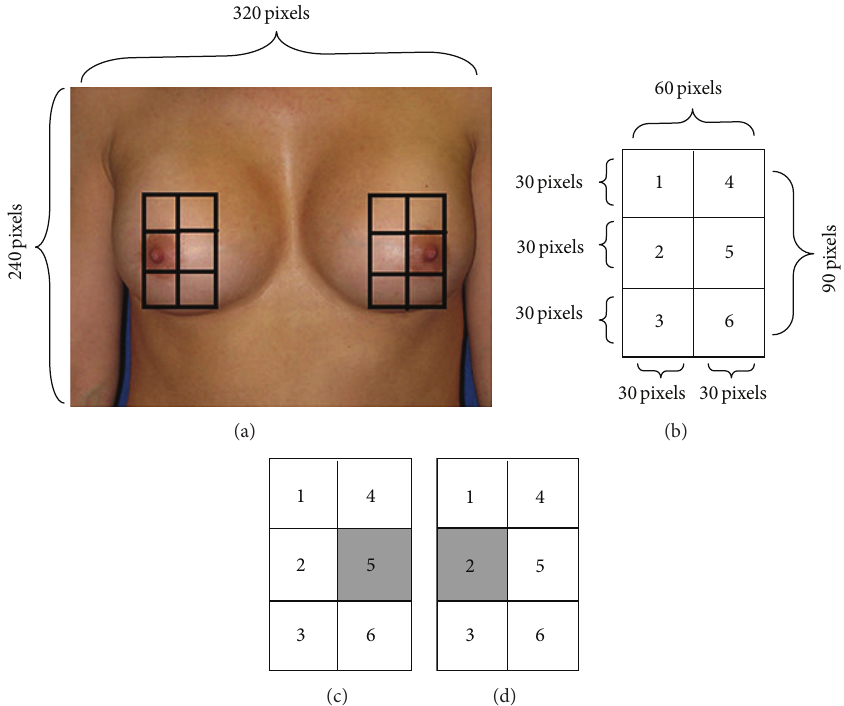
Figure 3: (a), (b) The structure of the ROI windows. (c) The sum of the pixels in 5th square must be less than others for left-nipple detection. (d) The sum of the pixels in 2nd square must be less than others for right-nipple